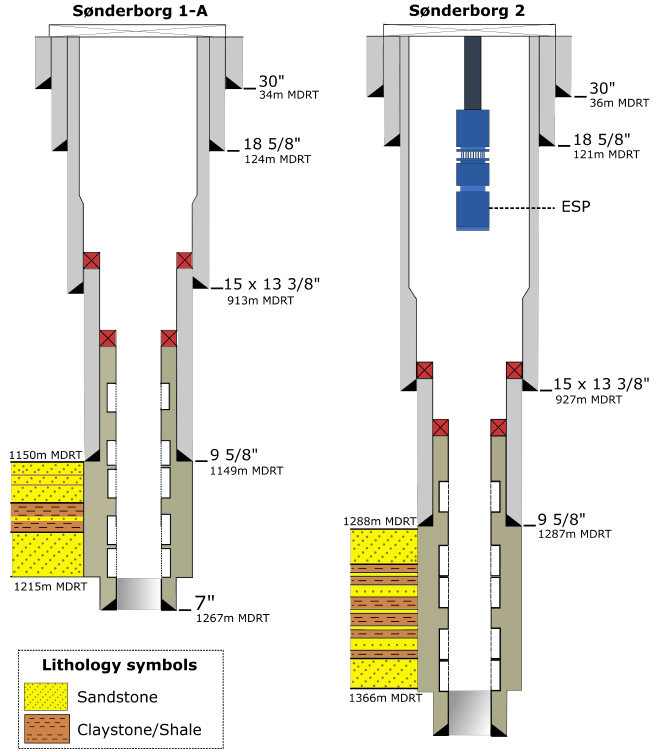
Figure 2. Graphical representation of completion design, well completions and casing sizes for Sønderborg-1A (injector) and Sønderborg-2 (producer). All the depths for the Sønderborg geothermal wells are in MDRT (measured depth below rotary table).